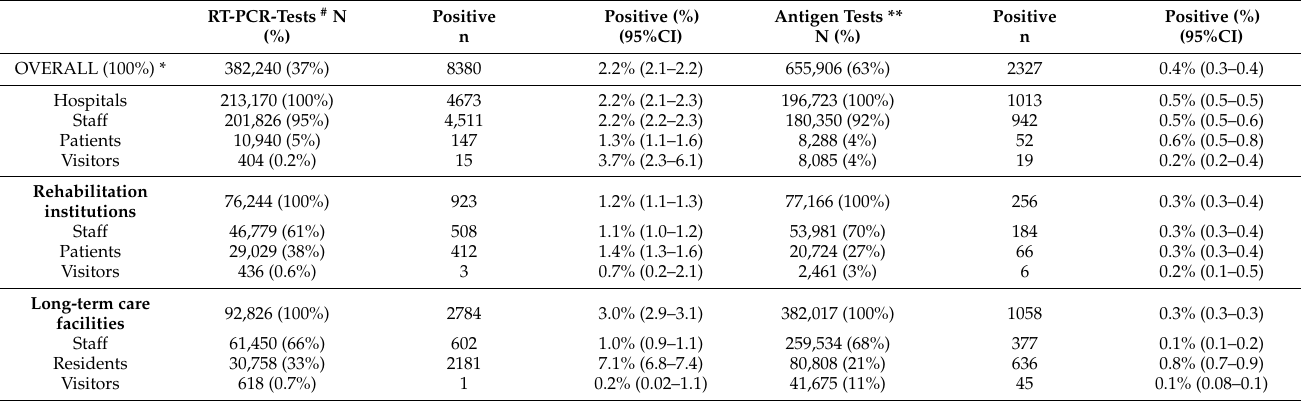
Table 1. Overview of accumulated SARS-CoV-2 screening tests and positive rates (grey columns) among asymptomatic persons in healthcare institutions in Bavaria,